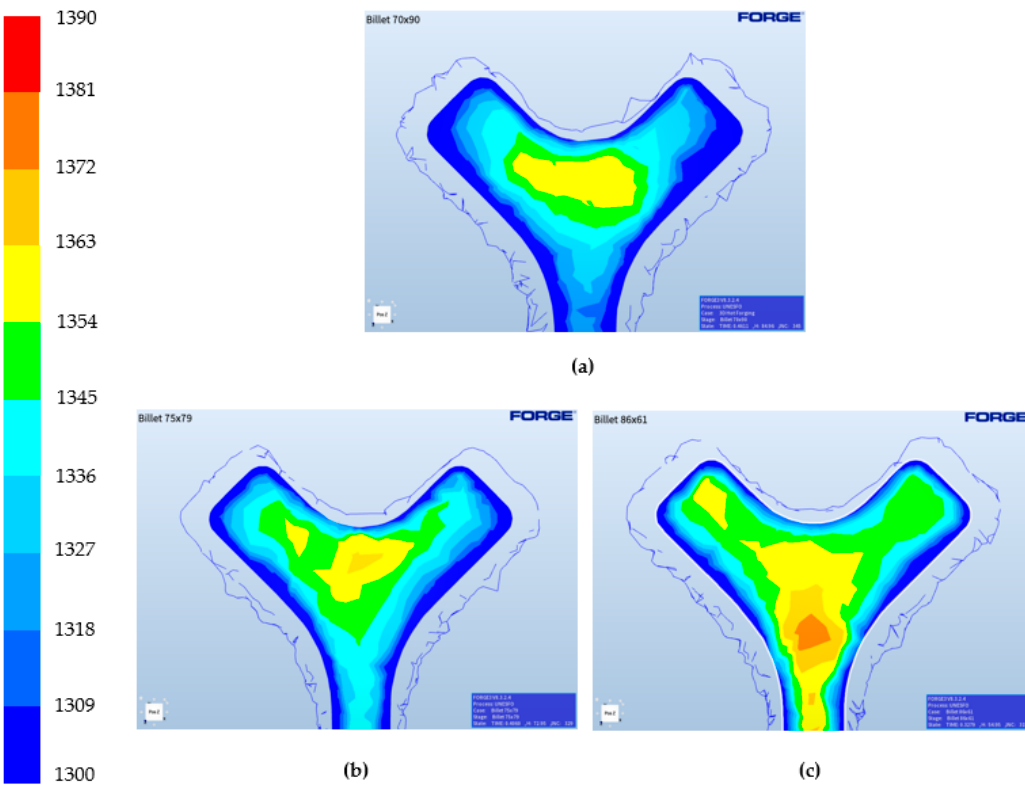
Figure 11. FORGE ® simulation results showing the temperature of the component in the last stages of deformation for different initial billet dimensions (in mm): ( a ) ø 70 × 90, ( b ) ø 75 × 79 and ( c ) ø 85 × 61. deformation for di ff erent initial billet dimensions (in mm): ( a ) ø70 × 90, ( b ) ø75 × 79 and ( c ) ø85 ×